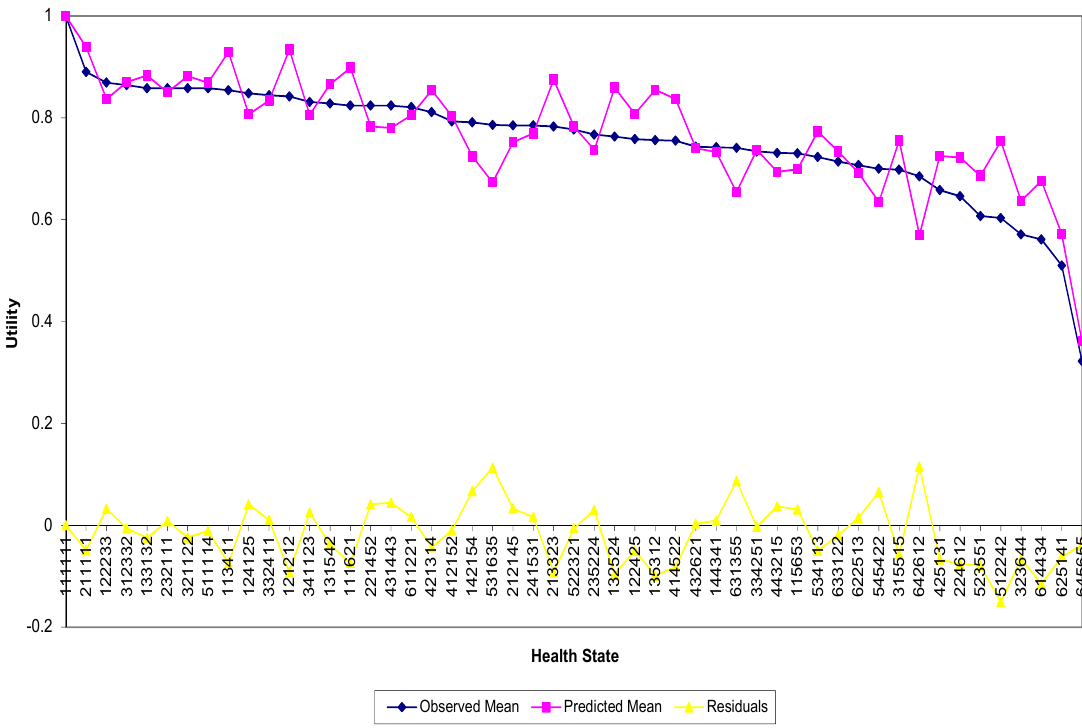
Figure 2. Actual and predicted health state valuations for the RE